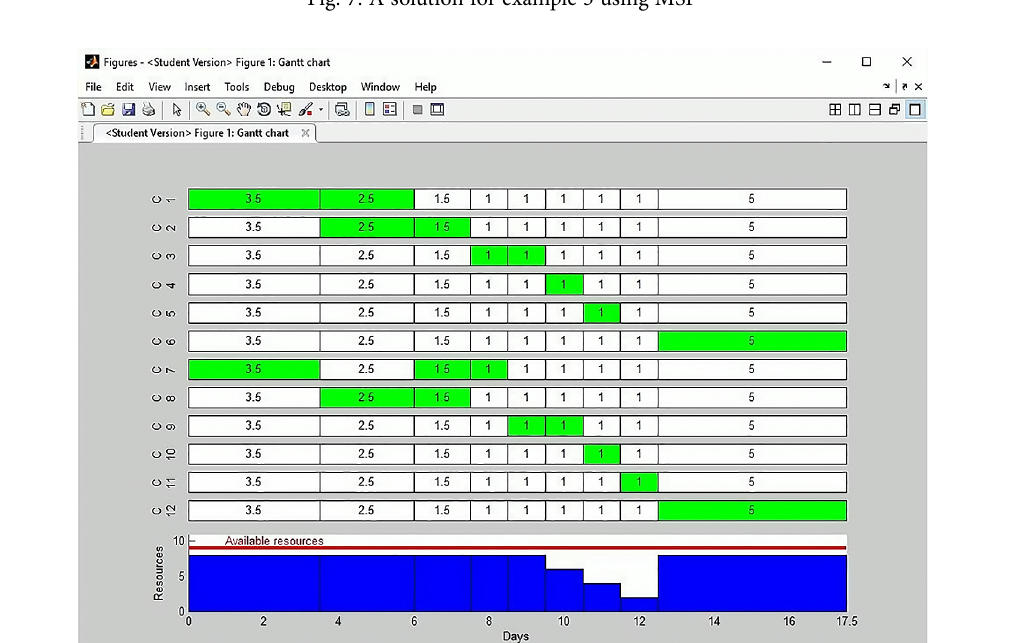
Fig. 8. A solution for example 3 using